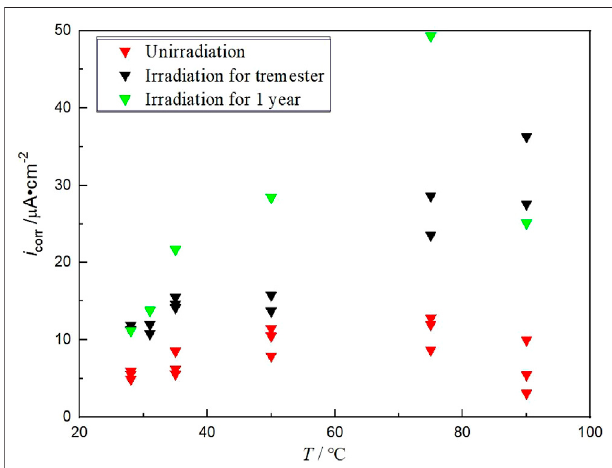
FIGURE 5 | Corrosion current density of Q235 steel unirradiated and irradiated for 3 months and 1 year in saturated highly compacted bentonite at different